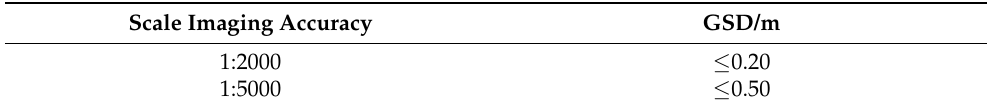
Table 2. GSD of the airborne-mapping camera.